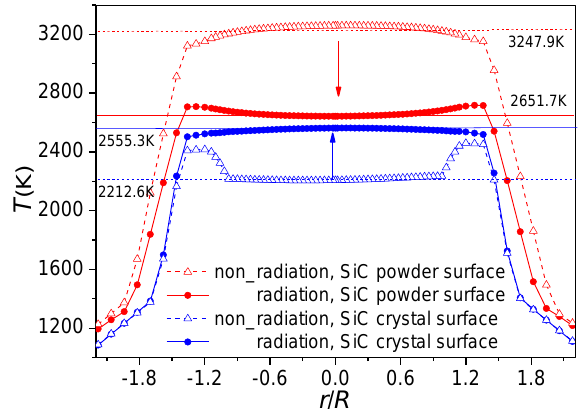
Figure 8. Temperature profiles on SiC powder surface and SiC crystal surface along with r-direction.